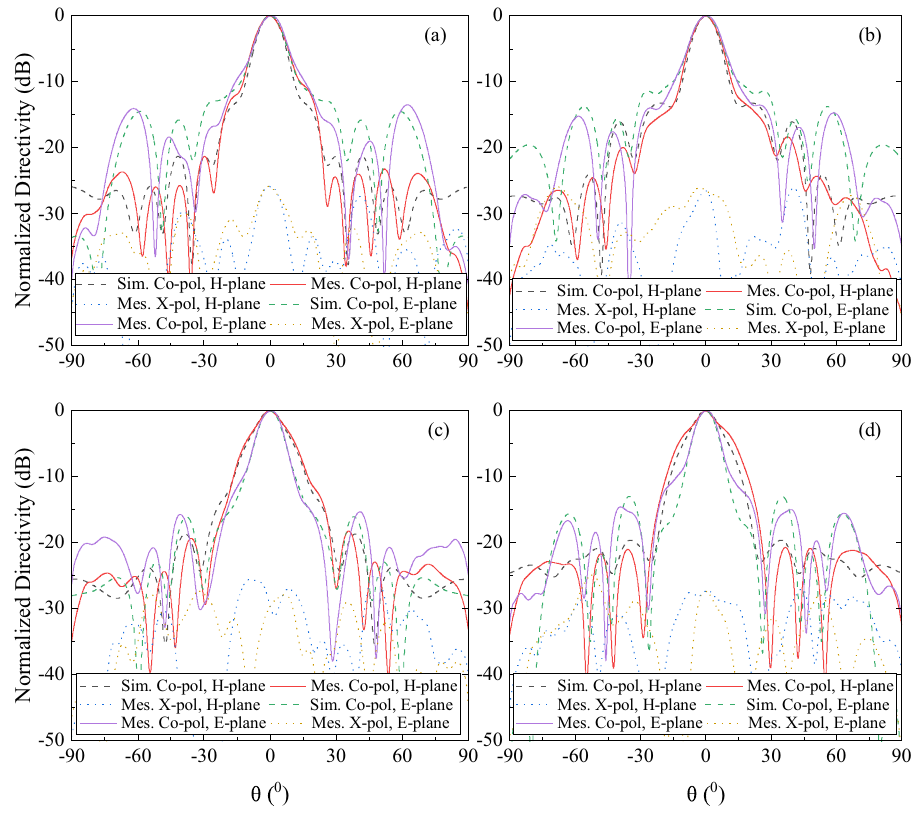
Figure 15. Measured and predicted far-field patterns of the RCA with DF-PTS at four frequencies. ( a ) 12.1 GHz, ( b ) 12.3 GHz, ( c ) 12.7 GHz and ( d ) 12.9 GHz.